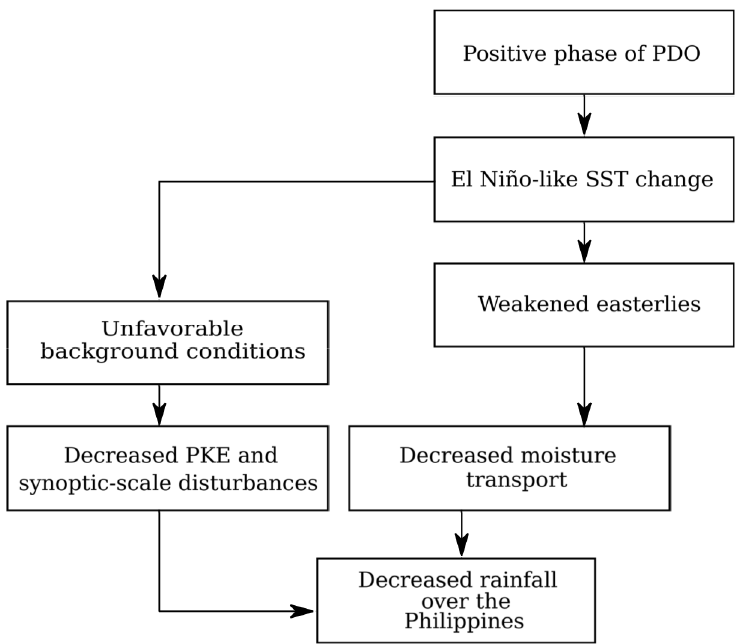
F igure 11. Schematic diagram showing the possible mechanisms leading to the decrease in rainfall during December during E2 (1977 1992) over the Philippines. PDO: Pacific Decadal Oscillation.